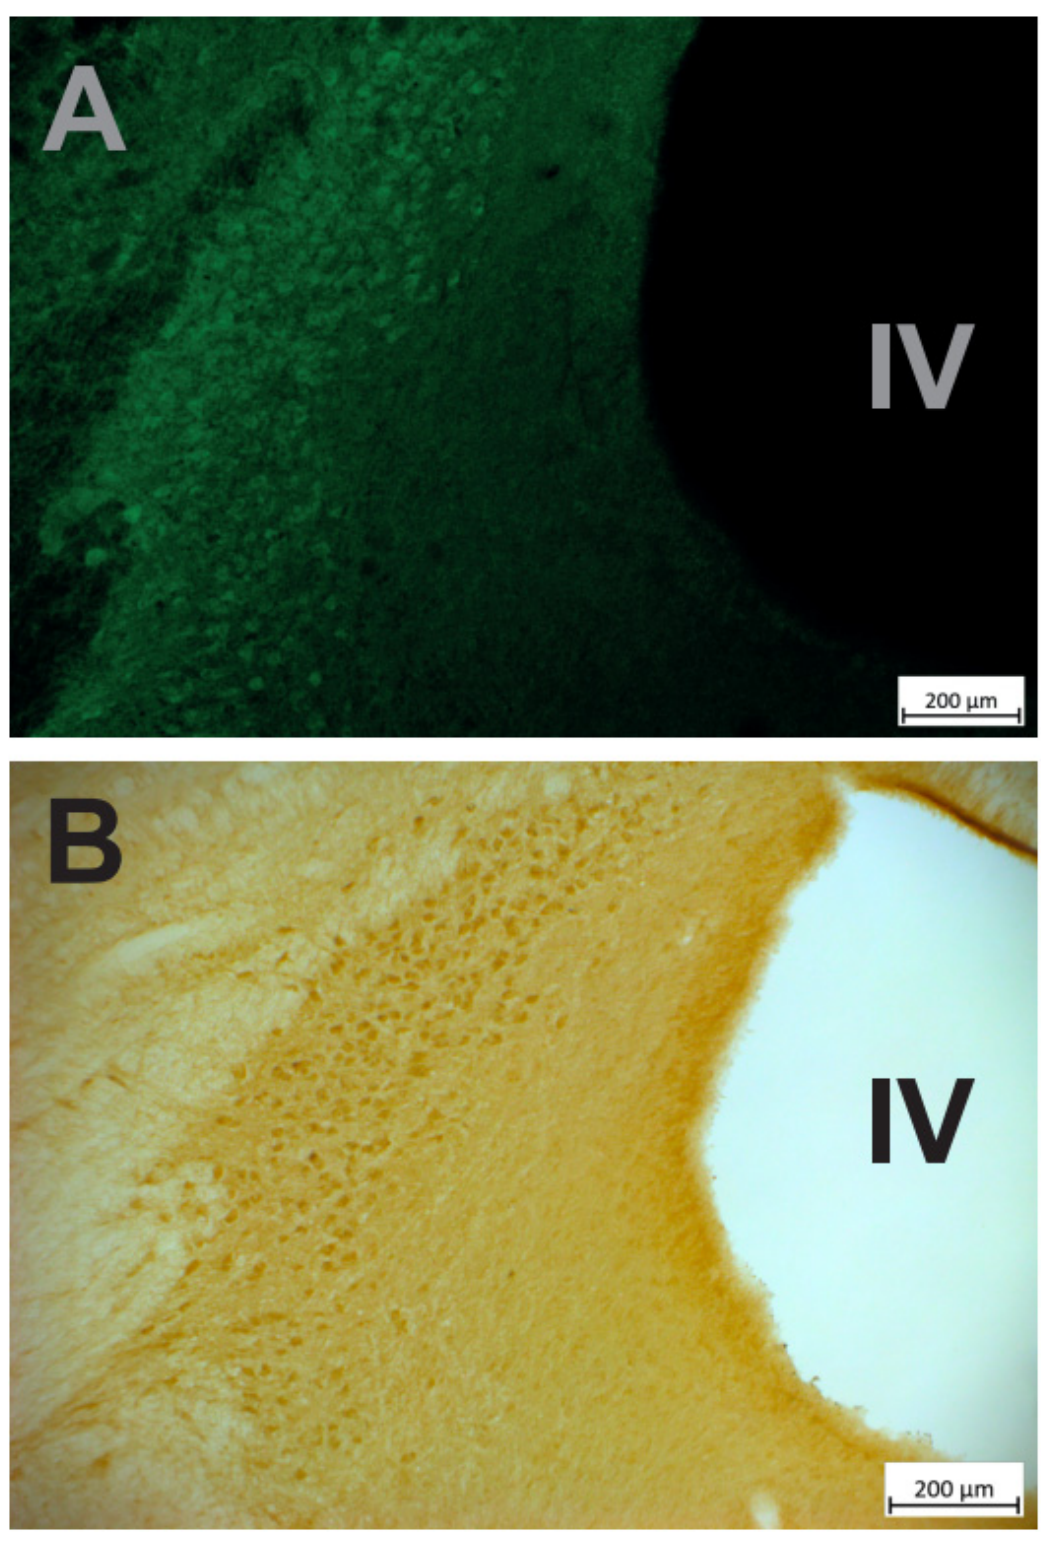
Figure 4. Immuno-detection of the DREADD. ( A ) Immuno-fluorescent labeling of the HM4Di-CFP DREADD, the LC is clearly visible, just lateral to the fourth ventricle (IV), in spite of the green background covering the entire section. ( B ) A neighboring section was treated with immuno-histochemistry to reveal the expression of the HM4Di-CFP DREADD. The LC is also clearly visible, with little staining in surrounding nuclei.